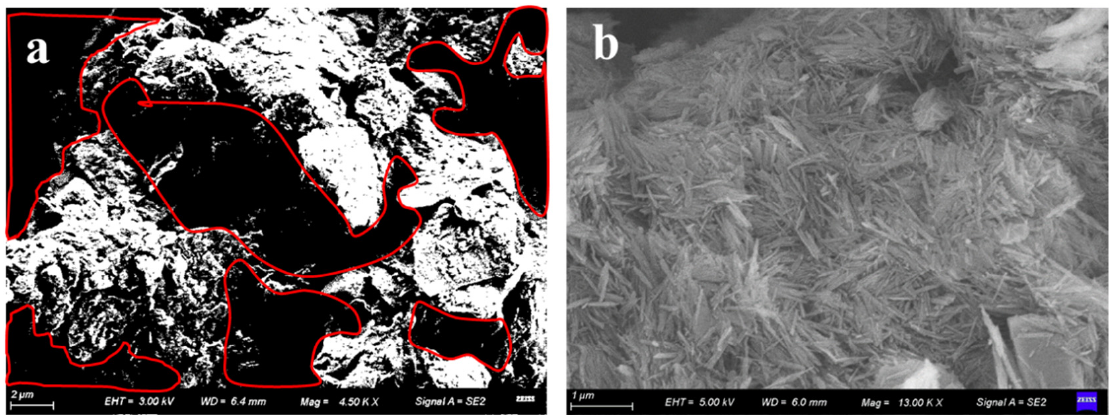
Figure 6. SEM test results of loess and attapulgite: ( a ) loess; ( b ) attapulgite.